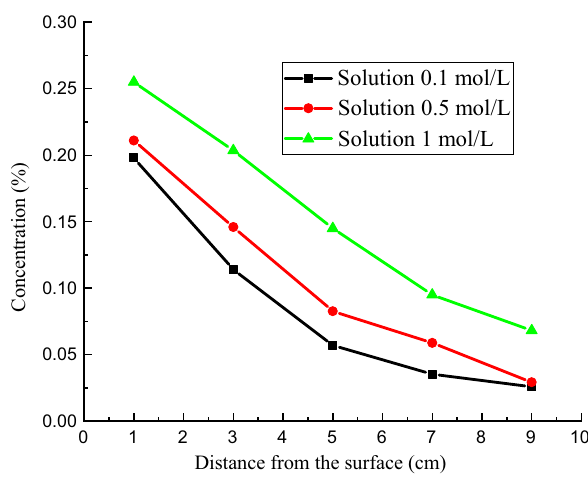
Fig. 3 Concentration of sulfate ion in the coal specimen being exposed 1 day